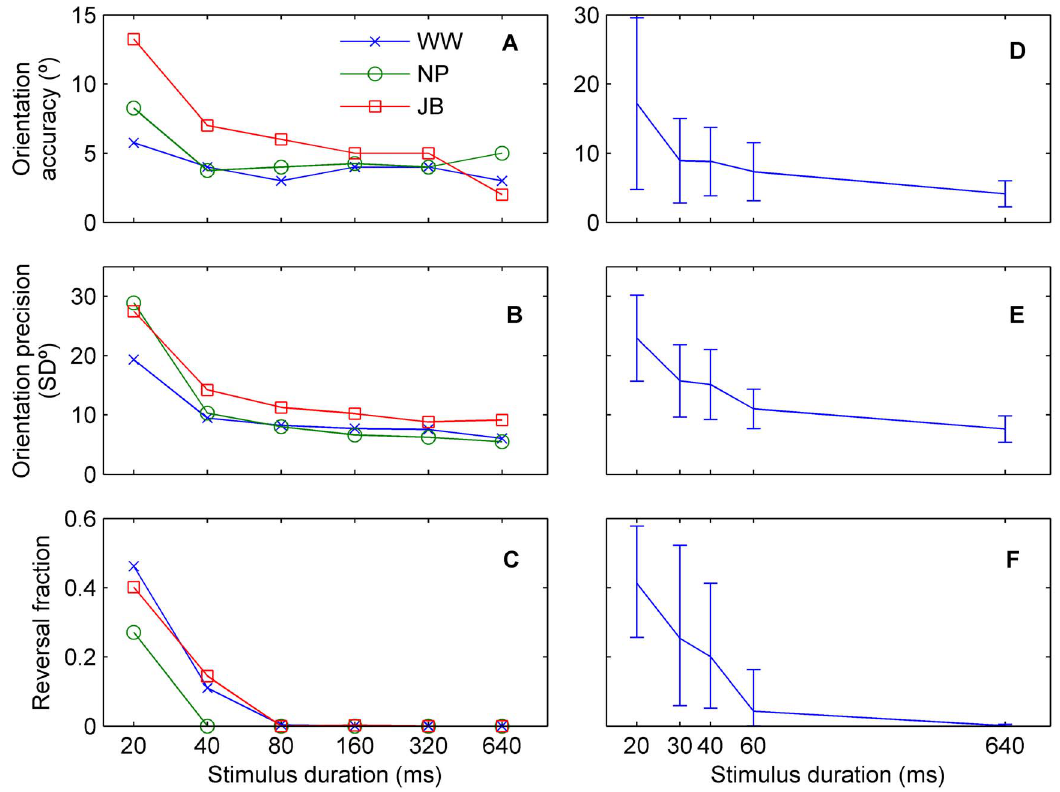
Figure 8. Duration-dependent perceptual performance. Increasing stimulus duration leads to better orientation accuracy (A, D), better orientation precision (B, E) and fewer reversals (C, F). Individual results are shown for three experienced observers (A–C) and for eleven participants (mean 6 SD ) tested over a different set of duration conditions (D–F).